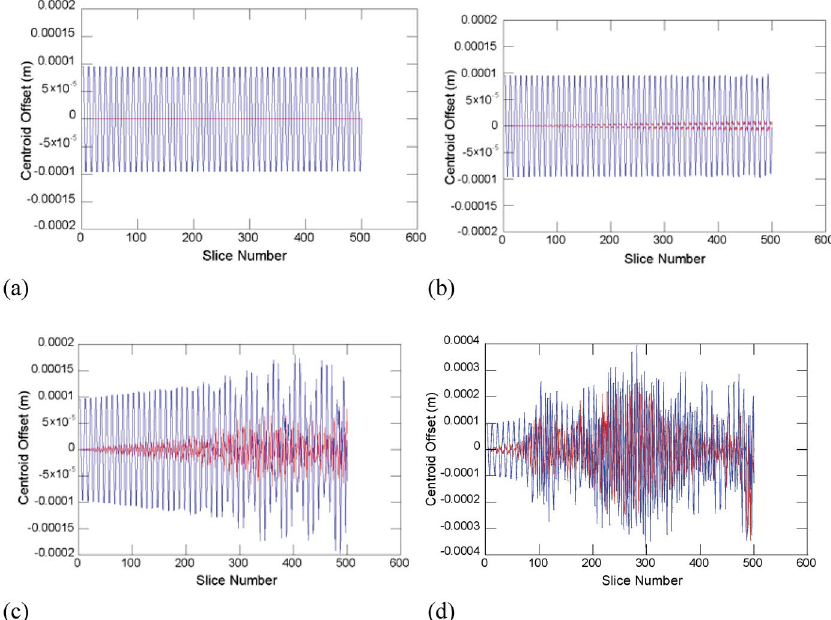
FIG. 23. (Color) Electron-beam centroid evolution for 20-MeV, 3-mm, nonresonant beam case at different axial positions. Each slice is 0.8 nsec long. The red line is for the horizontal offset and the blue dashed line is for the vertical offset. (a) z (cid:4) 0 : 2 m , (b) z (cid:4) 0 : 625 m , and (c) z (cid:4) 1 : 25 m , and (d) z (cid:4) 5 m